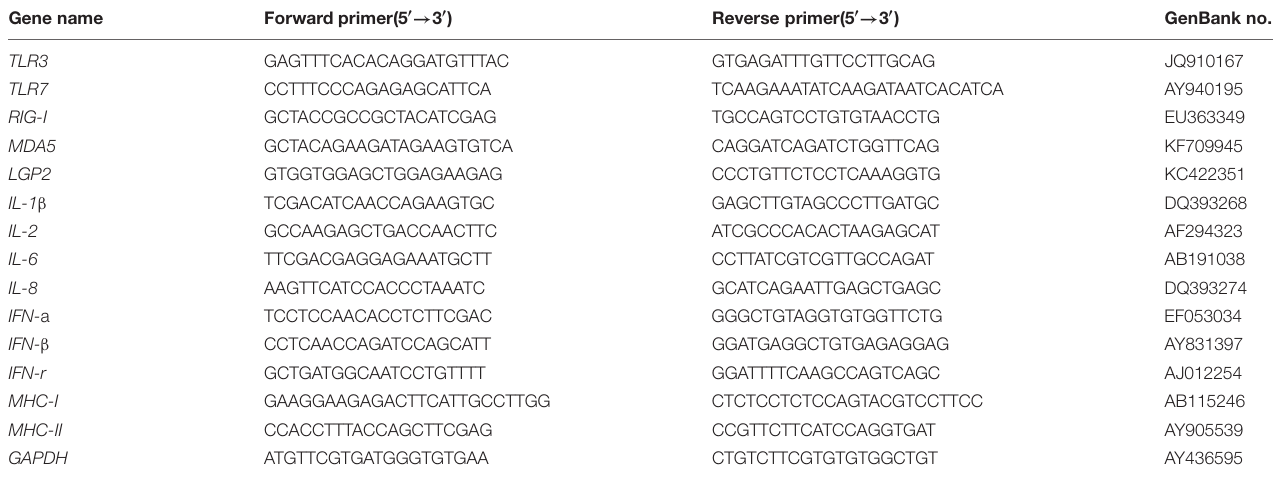
TABLE 1 | Quantitative real-time PCR primers used in this